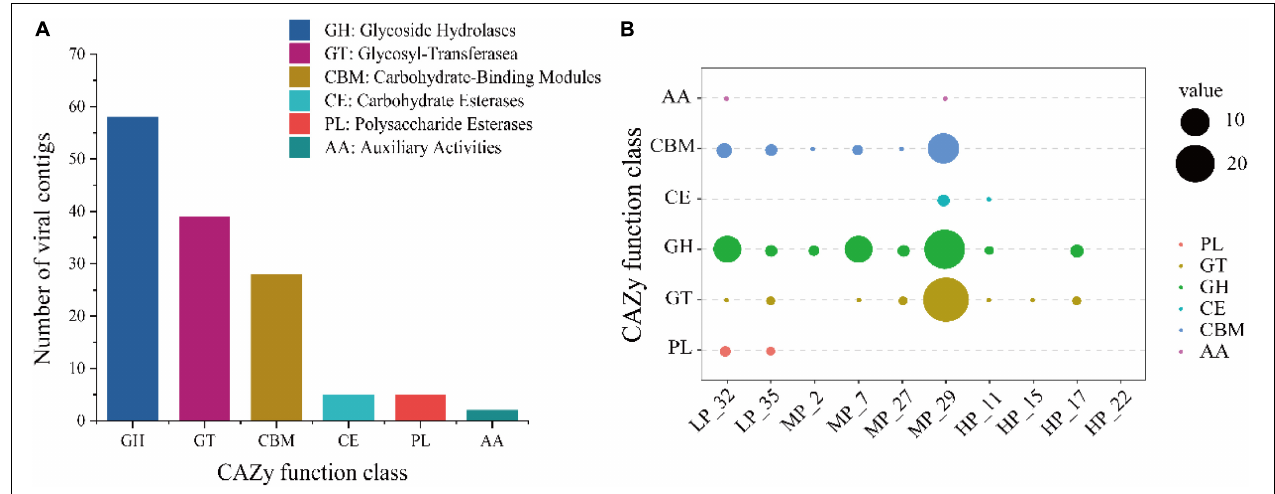
FIGURE 5 | Abundant auxiliary CAZyme from surface soil viruses in the Tibetan Plateau. Annotation of viral carbohydrate metabolism-related contigs ( > 10 kb) in the CAZy database (A) . The distribution of viral auxiliary CAZyme in each sample (B)